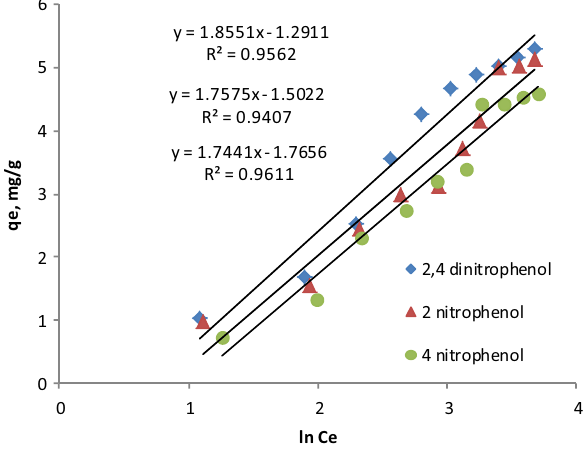
Fig. 5 Temkin model of phenols on char